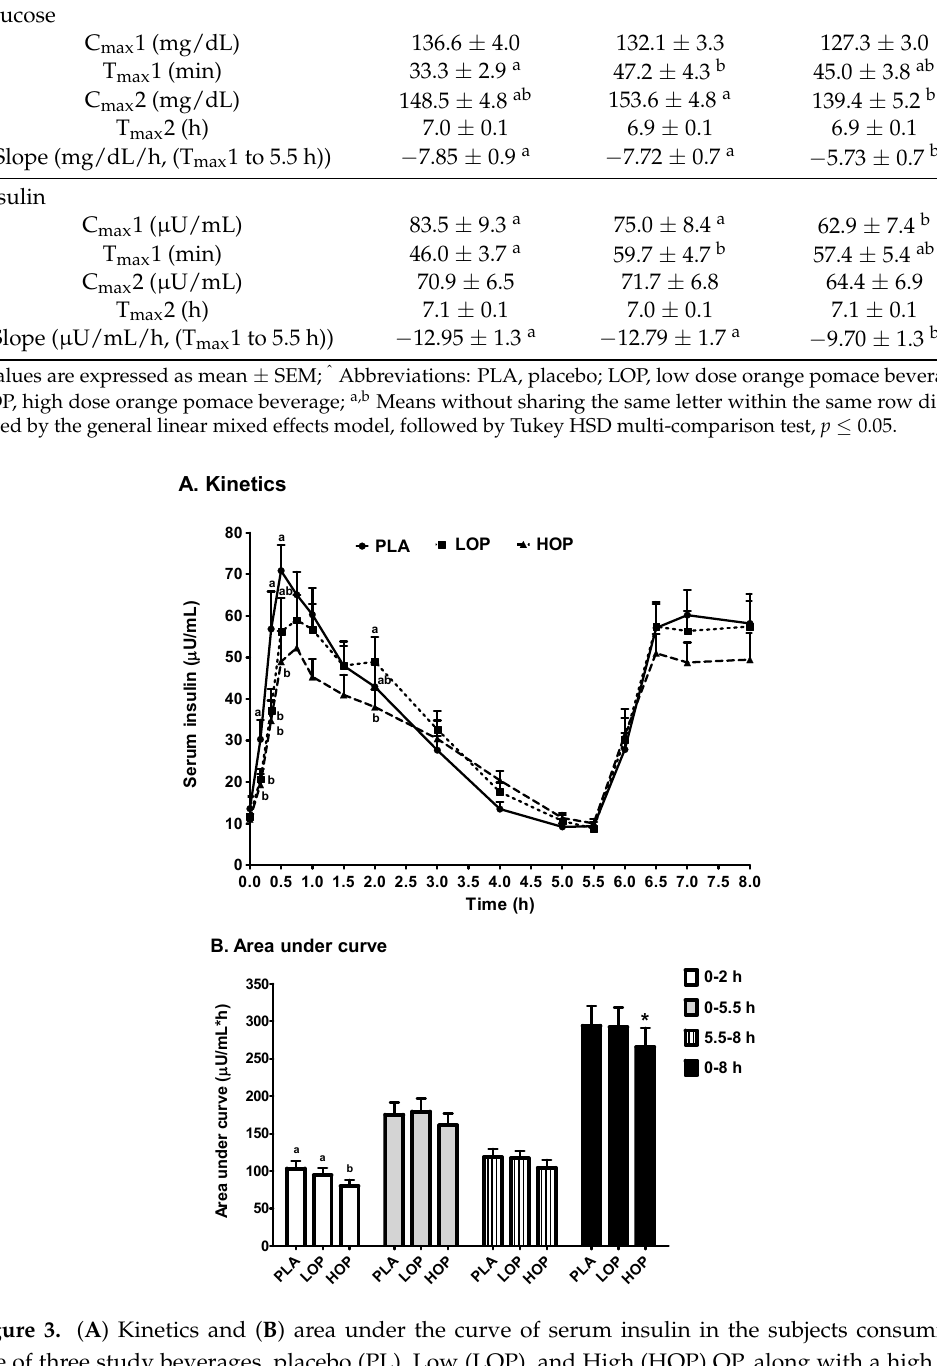
Table 3. The maximum glucose and insulin concentrations (C max ) in serum and the time to reach the C max (T max ) in subjects consuming a high fat, carbohydrate breakfast along with a beverage containing placebo, 35% (LOP) or 77% (HOP) orange pomace *.